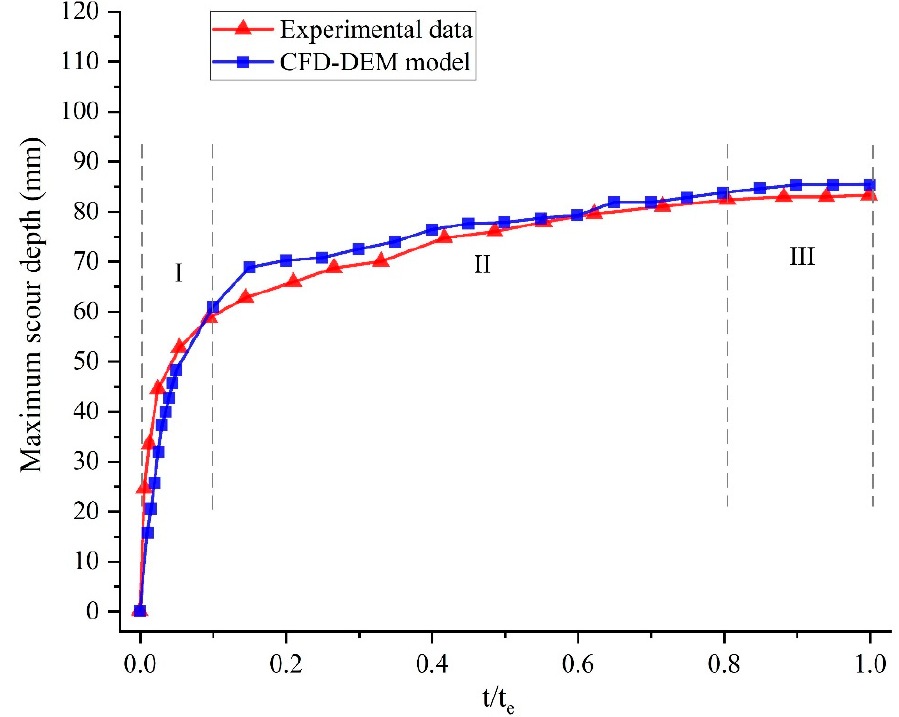
Figure 10. Time history of the maximum scour depth. I, II, III represent the initial stage, intermediate stage and equilibrium stage of scouring respectively.